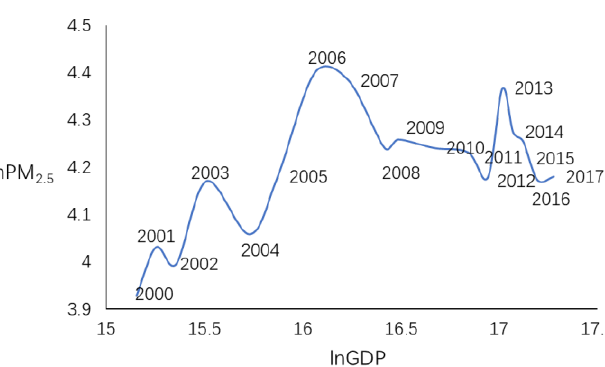
Figure Figure 4. The relationship between lnGDP and lnPM 2.5 in Beijing-Tianjin-Hebei region and surrounding cities.